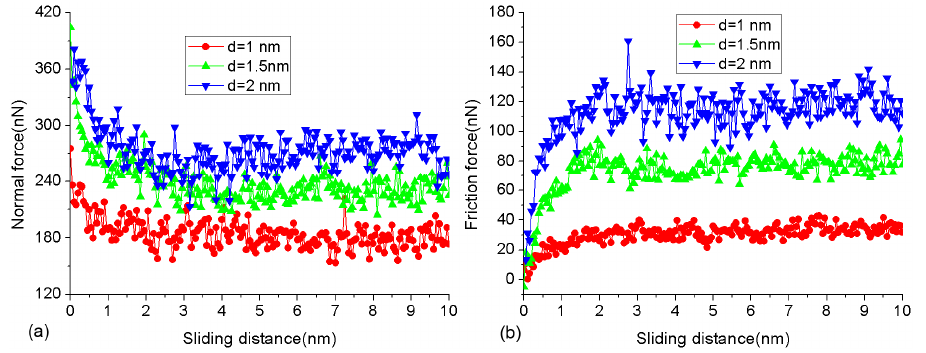
Figure 7. Force-displacement curves in the scratching process for different scratching depths. ( a ) normal force and ( b ) friction force.